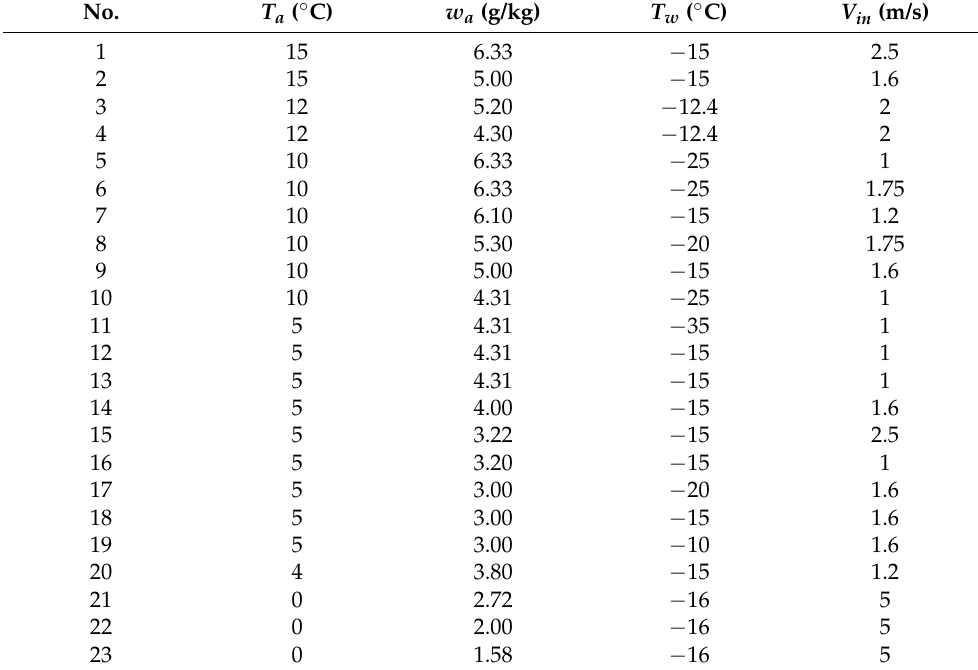
Figure 7. Operating points for numerical model classified by proposed procedure [8,9,18,22,23,38,39]. I: super-cooled water droplets, II: irregular crystals, III: flake crystals, IV: needle and pole crystals, and V: feather crystals. Table 3. Testing conditions of the points used in the numerical model.